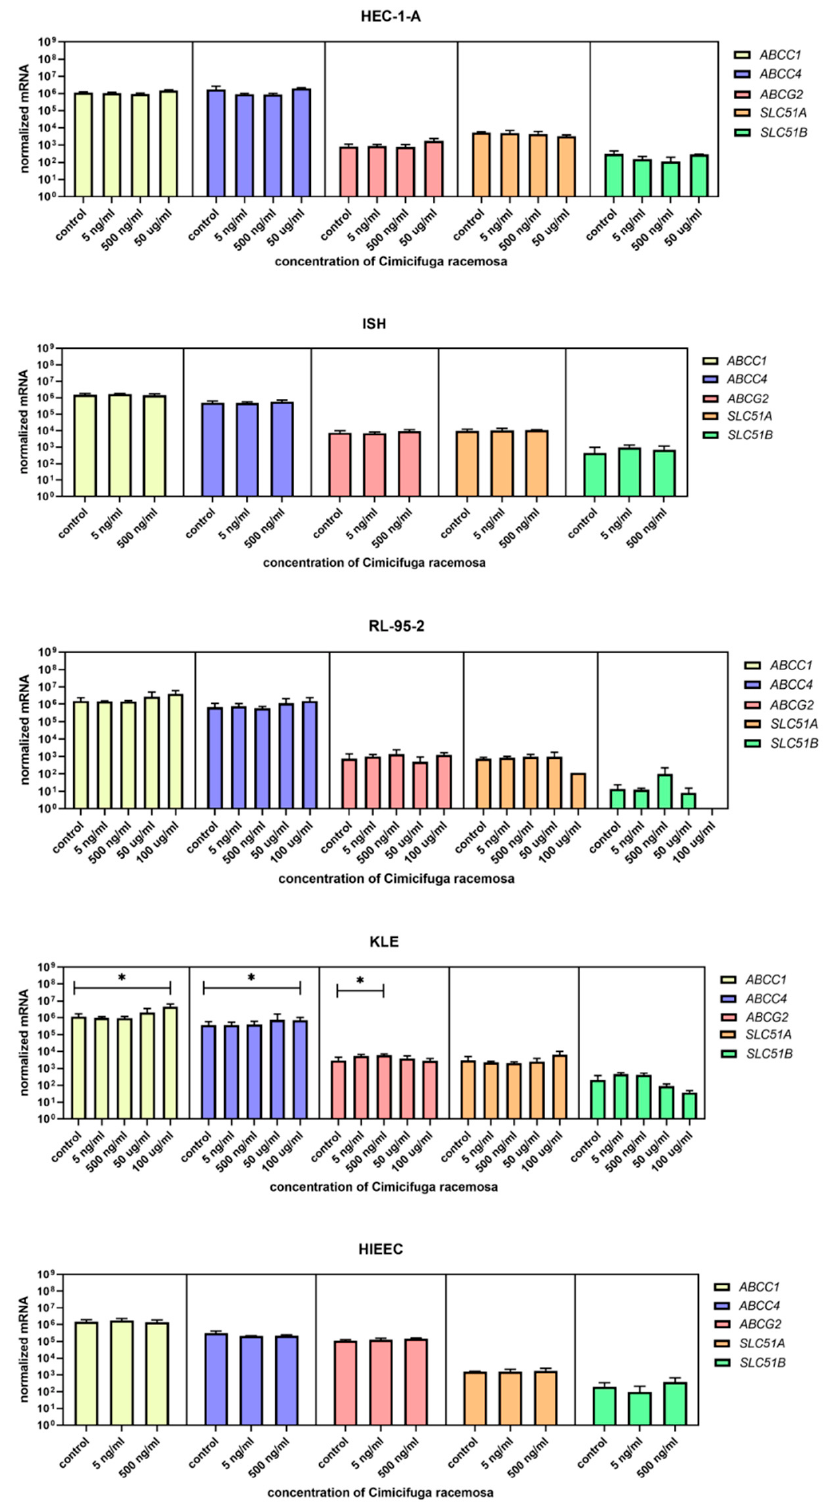
Figure 5. Normalized expression of five different genes of efflux ( ABCC1 , ABCC4 , ABCG2 , SLC51A , SLC51B ) in endometrial cancer cell lines HEC-1-A, Ishikawa, RL-95-2, and KLE and control cell line HIEEC. At least three independent experiments were performed. Data are shown as mean ± SD. * p -value ≤ 0.05.